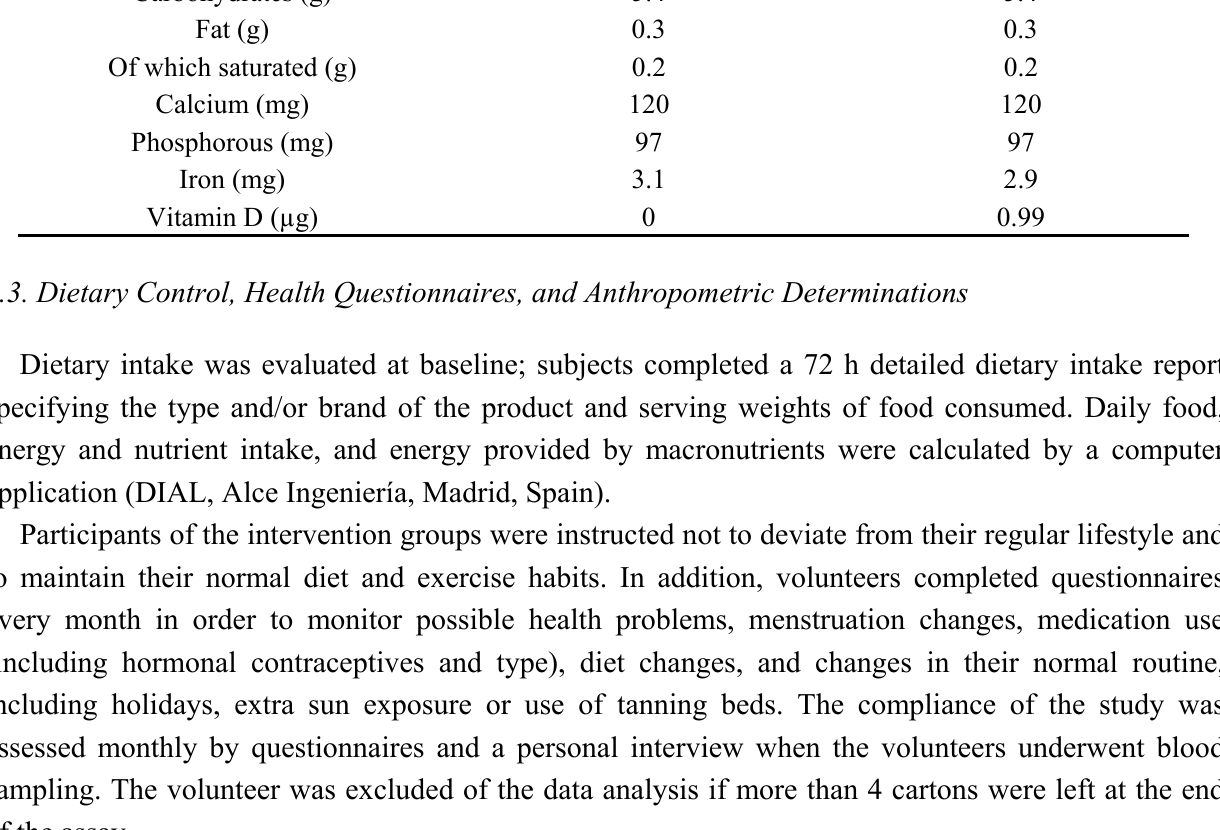
Table 1. Composition of the dairy products (per 100 mL). Ingredients: skimmed milk, sugar, sucralose, stabilizers (E-452, E-412, E-407, E-339), carotens (E-160a), vanilla flavouring, microencapsulated ferric pyrophosphate, and cholecalciferol (D-fortified product). Component D-Placebo Dairy Product D-Fortified Dairy Product Energy (kcal) 37 (156 kJ) 37 (156 kJ) Proteins (g) 3.1 Carbohydrates (g) Fat (g) 0.3 0.3 Of which saturated (g) 0.2 0.2 Calcium (mg)